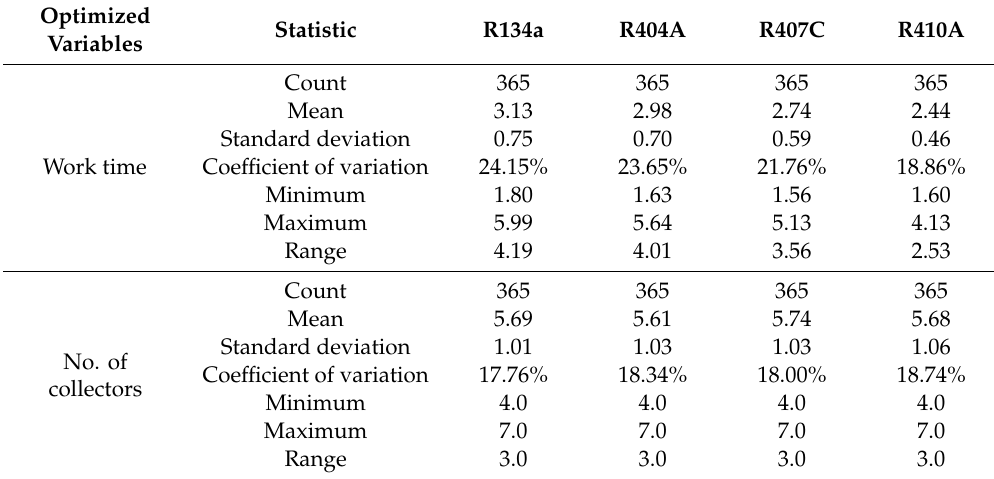
Table 7. Main statistics of the optimized